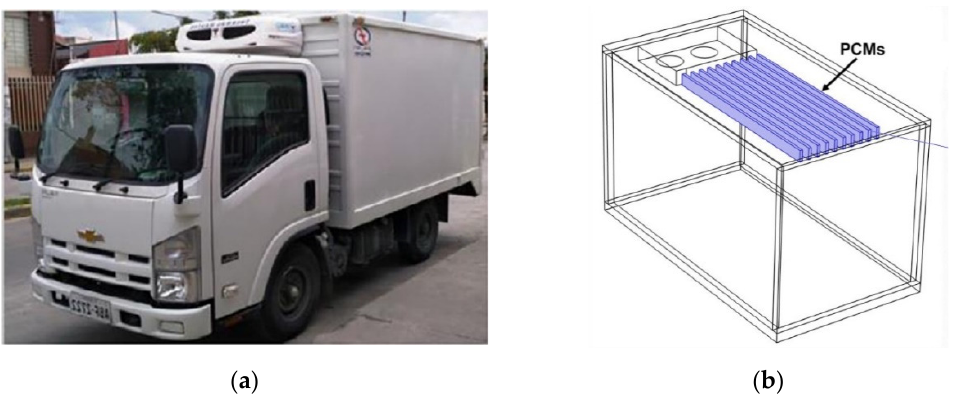
Figure 4. ( a ) Commercial refrigerated truck; ( b ) 3D model of the PCM incorporated truck. [75] Table 5 provides an overview of the use of PCM in refrigerated transport and storage. Although many researchers have expressed interest in the cold chain, few researchers have explicitly studied the refrigerated transporter PCM. Table 5. Summary of studies reported with the use of PCM in refrigerated